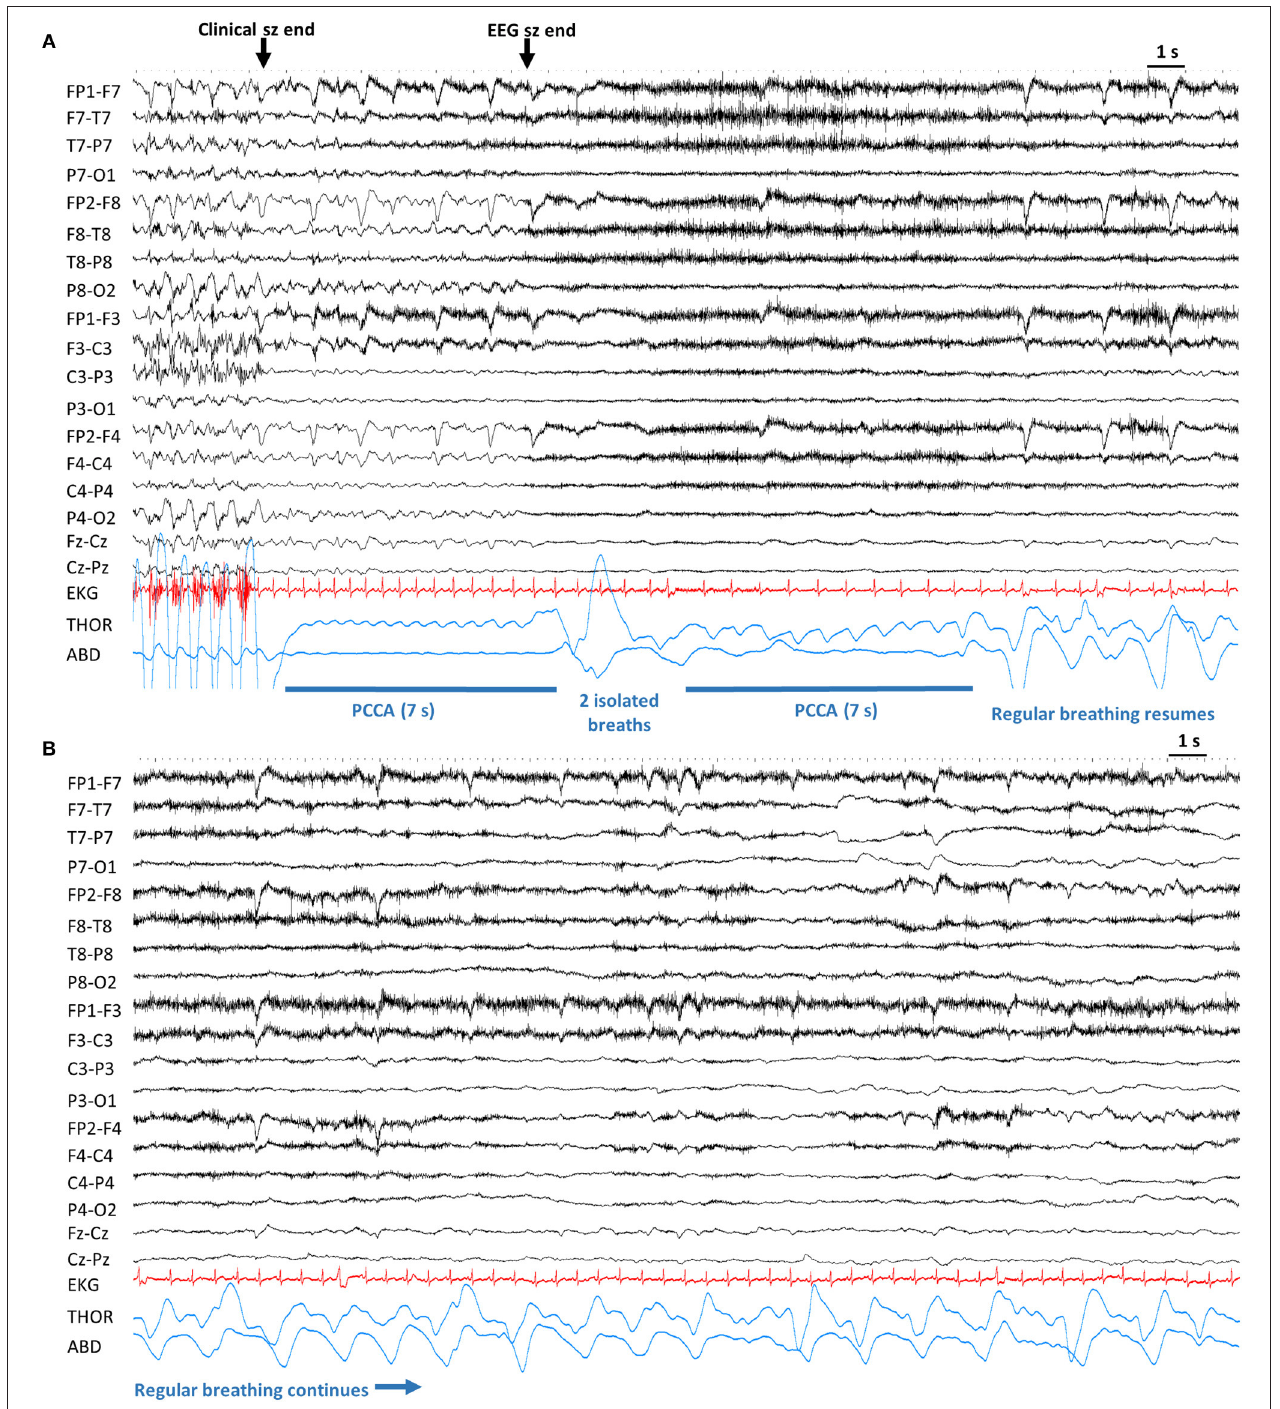
FIGURE 3 | Example of post-convulsive central apnea (PCCA). Sensitivity 20 µ V, High Frequency Filter: 70Hz, Time constant: 0.1s. (A) . After the end of convulsive phase, the patient is apneic for 7s. After the electrographic end, there are 2 noticeable breaths which are followed by another brief apnea. Lastly, regular breathing resumes. (B) Continuation from (A) , regular breathing continues. ABD, abdominal; Clinical sz end, end of clinical seizure. EEG sz end, electrographic seizure end; EKG, electrocardiogram; PCCA, post-convulsive central apnea; s, seconds; THOR, thoracic.